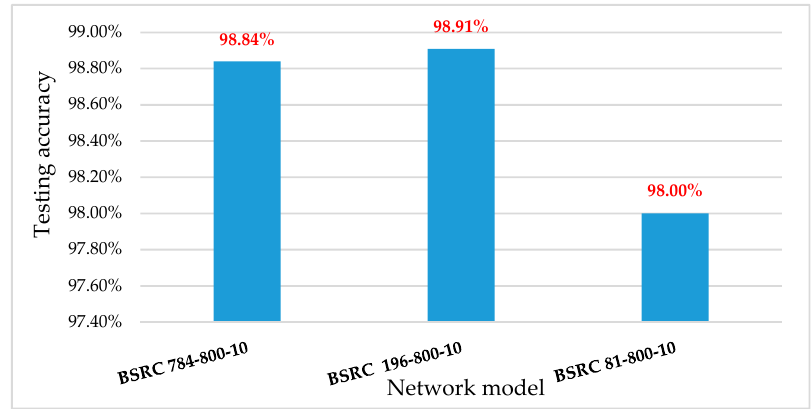
Figure 4. Testing accuracy of SNNs with one hidden layer of 800 nodes. BSRC (28 × 28 − 14 × 14 − 9 × 9) 4-bit per Pixel. Electronics 2020 , 9 , x FOR PEER REVIEW